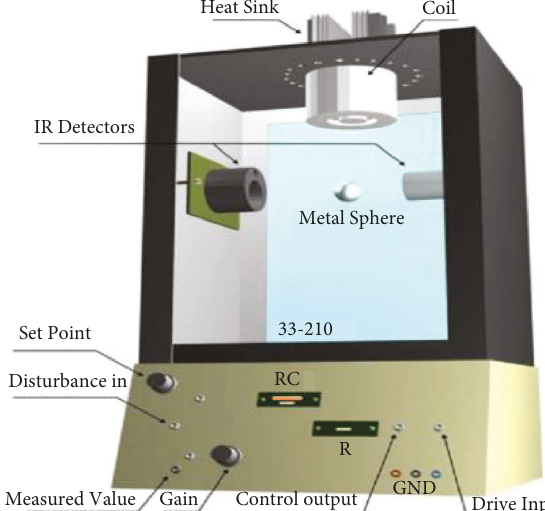
Figure 1: Magnetic levitation